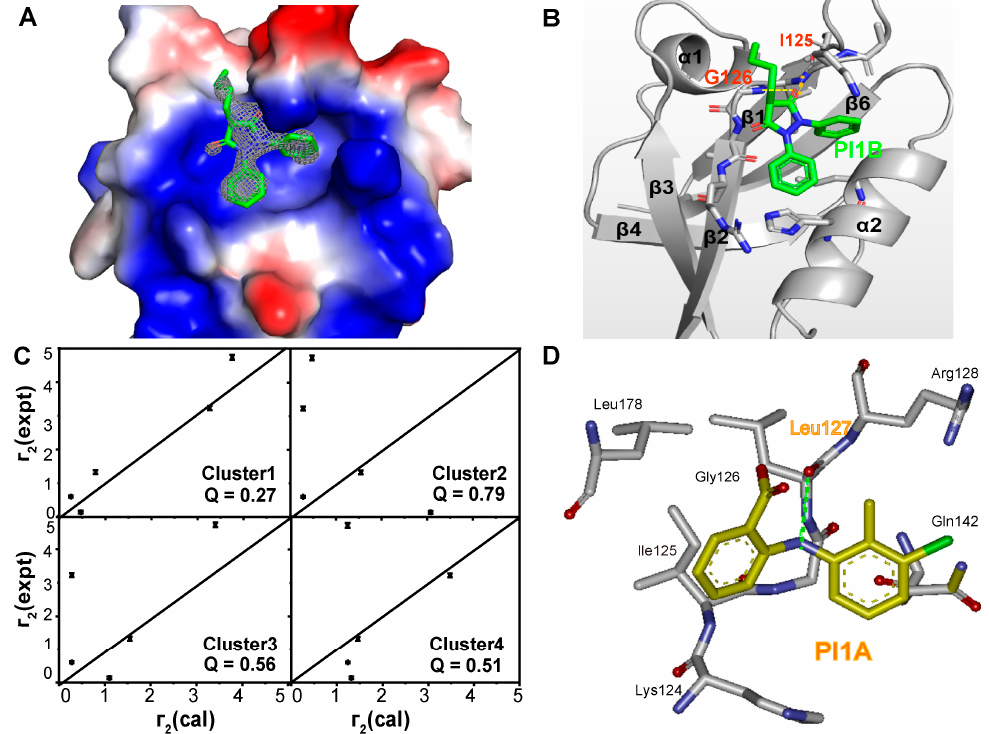
Figure 2. The binding modes of PI1B and PI1A to MDA-9 PDZ1 domain. ( A ) The electrostatic surface representation of the crystal structure of MDA-9 PDZ1 domain in complex with PI1B (PDB ID: 8HCK). The 2Fo-Fc electron-density map of PI1B is contoured at 1 σ (gray mesh). ( B ) Detail interactions between protein and ligand. The secondary structure elements are labeled in the crystal structure of MDA-9 PDZ1. The green dash lines represent hydrogen bonds. ( C ) Correlations between the experimental ( Γ 2(expt) ) and back-calculated ( Γ 2(cal) ) PRE values for the lowest energy pose in each cluster. The black solid squares indicate the experimental and back-calculated PRE values for each H atom of PI1A and annotated with experimental errors. ( D ) Detailed interactions between MDA-9 PDZ1 domain (carbon atoms in gray) and PI1A (yellow).